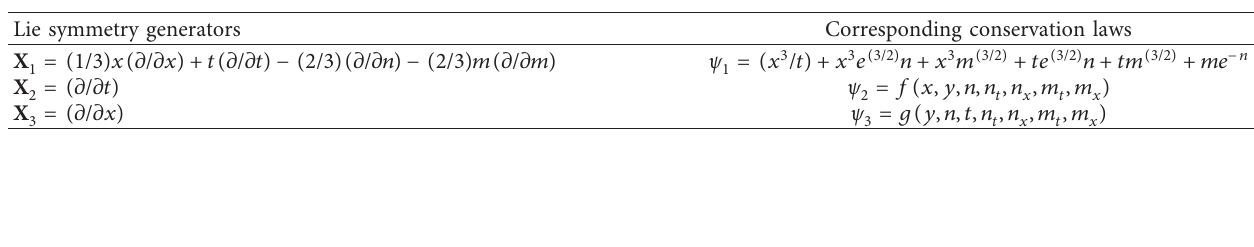
Table 6: Lie symmetry generator and corresponding conservation laws.